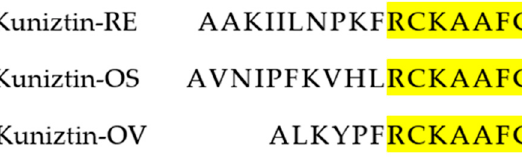
Figure 2. The primary structure of the novel Kunitzin-OV from Odorrana versabilis skin secretion compared with other kunitzins. Fully conserved residues are highlighted.